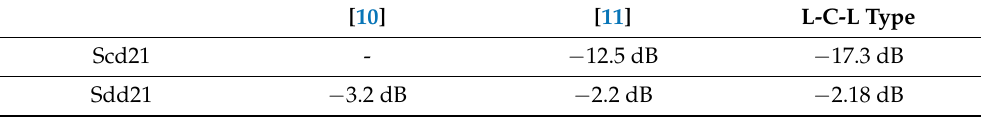
Table 6. Comparative analysis with results from other literature solutions for Scd21 and